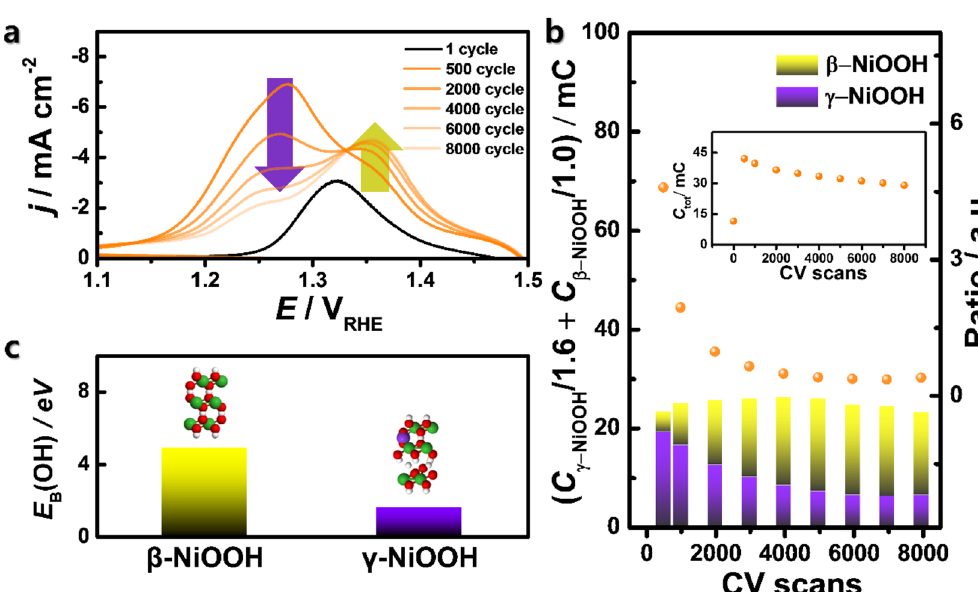
Figure 5. ( a ) Cyclic voltammograms (CVs) of Ni 2 P/C at the negative scans, ( b ) normalized charges assigned to the reduction current related to β -NiOOH and γ -NiOOH, estimated by the deconvolution of the CVs in ( a ) by considering different electron transfer numbers (shown in Fig. 1). Inset: calculated total reduction charges of the CVs in ( a ) and the estimated molar ratio of γ -NiOOH to β -NiOOH in repeated potential cycles, and ( c ) binding energy of OH ( E B (OH)) for β -NiOOH and γ -NiOOH, calculated by density functional